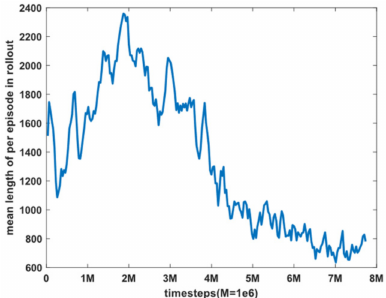
Figure 14. Mean length per episode in the training